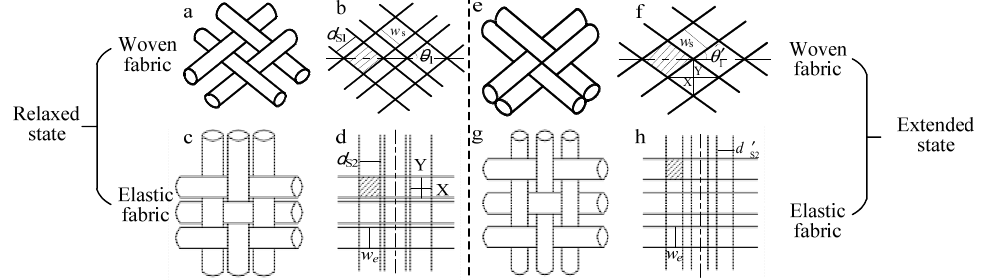
Figure 5. Shape of the fabric layers in different states. ( a ) Woven fabric in relaxed state and ( b ) is schematic. ( c , d ) Elastic fabric in relaxed state. ( e , f ) Woven fabric in extended state. ( g , h ) Elastic fabric in extended state.